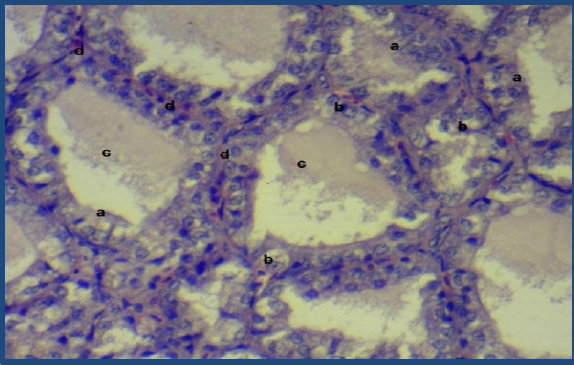
Figure, 7: Thyroid gland showed: a- Highly active thyroid follicles lined by cuboidal to columnar epithelium b- Nucleus: round-oval, centrally located with 1-2 nucleoli c- colloid d- Very little stroma between follicles (H and E stain,